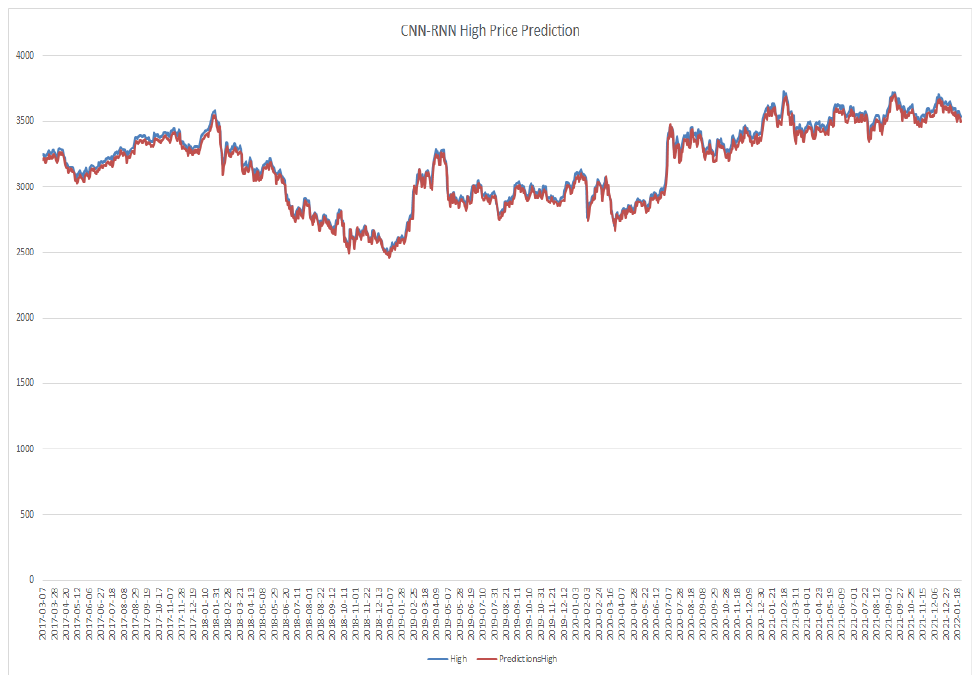
Figure 15. CNN-RNN model high price